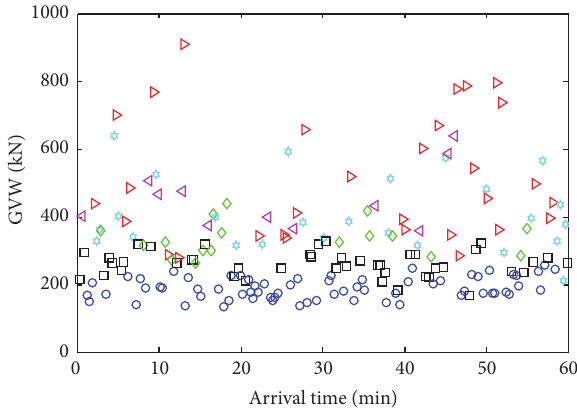
simulated stochastic traffic load model in 60 min is shown in Figure 3. Note that the individual GVW is used instead of the axle weight for the convenience of